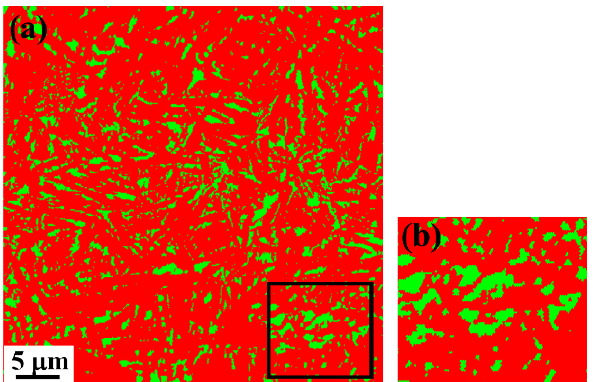
Figure 9. ( a ) EBSD phase map showing the green-colored RA (FCC) islands in the red-colored bainitic ferrite matrix with martensite packets (BCC). ( b ) Enlarged phase map view of the rectangle shown in ( a ).